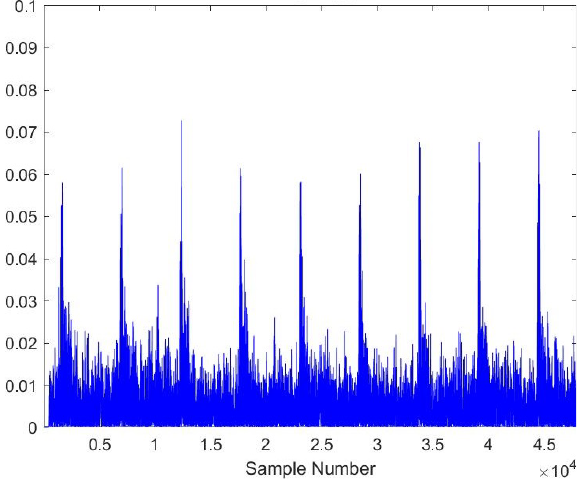
Figure 8. RMS plot of Softwood, Average Tool, 2 mm depth-of-cut.